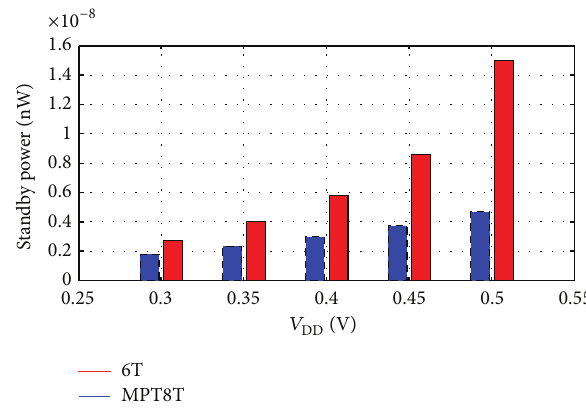
Figure 20: Write access time versus 𝑉 DD .